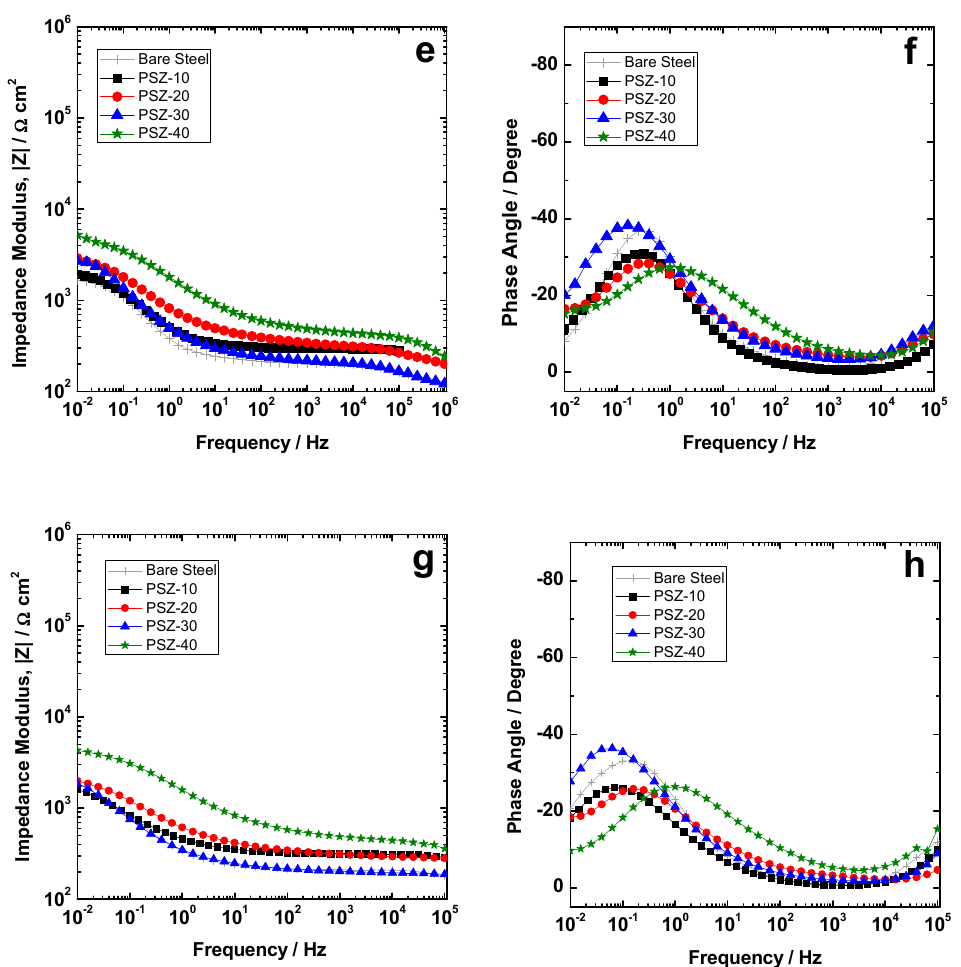
Figure 7. Modulus and phase spectra of the investigated coatings compared to the bare substrate during immersion time: ( a , b ) 1 h, ( c , d ) 24 h, ( e , f ) 72 h, and ( g , h ) 168 h.